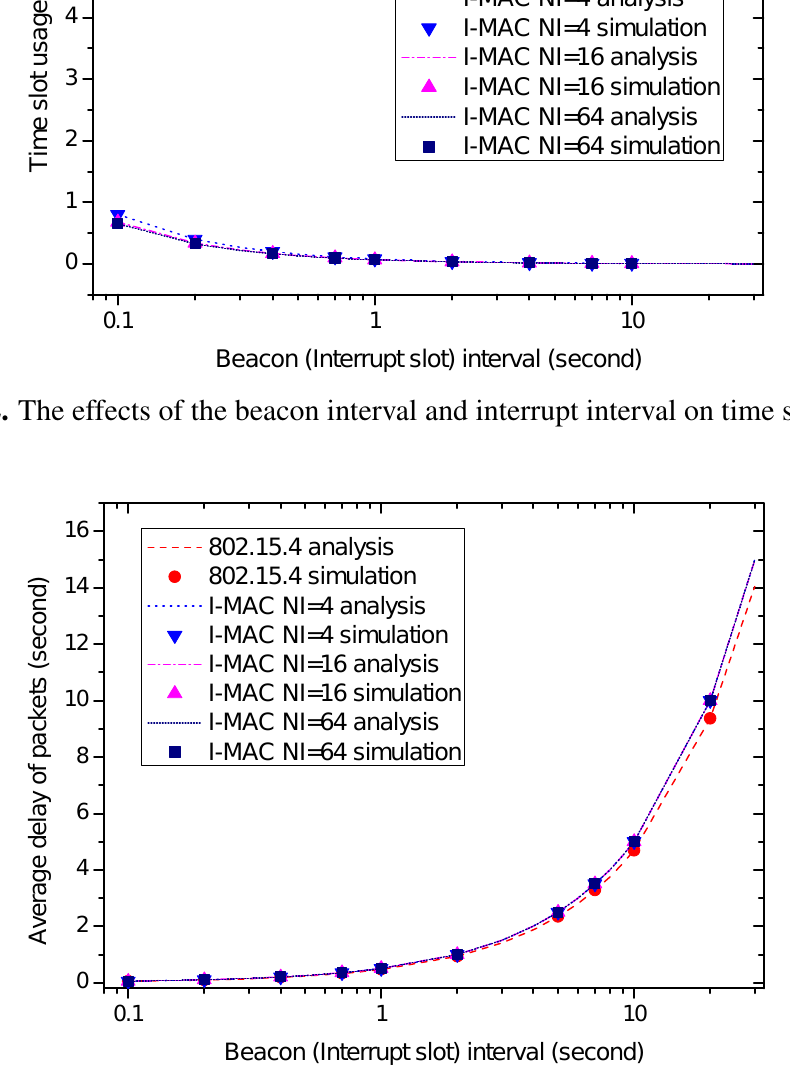
Figure 13. The effects of the beacon interval and interrupt interval on average packet